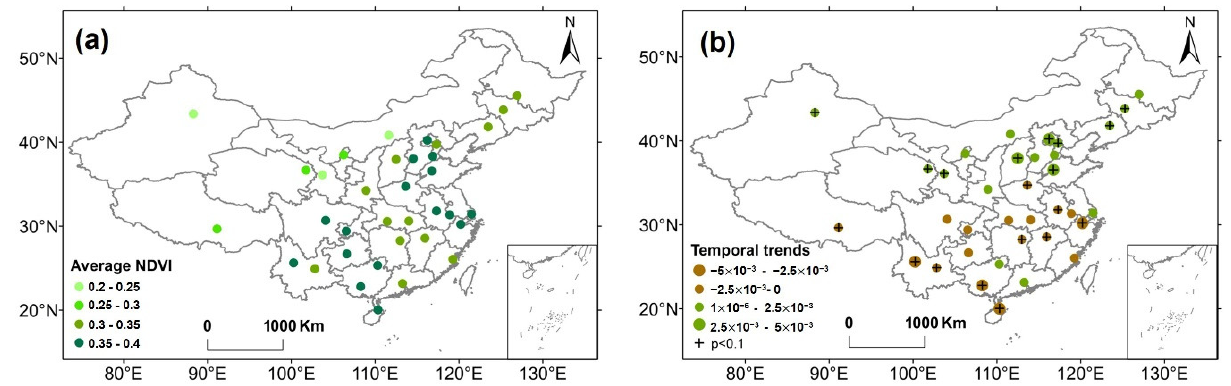
Figure 3. ( a ) Average NDVI across all the selected 35 cities during 2000–2020; ( b ) Spatial distribu- tions of temporal trends of NDVI across all the selected 35 cities during 2000–2020. Green dots indi- cate vegetation greening, and brown dots indicates vegetation degradation.